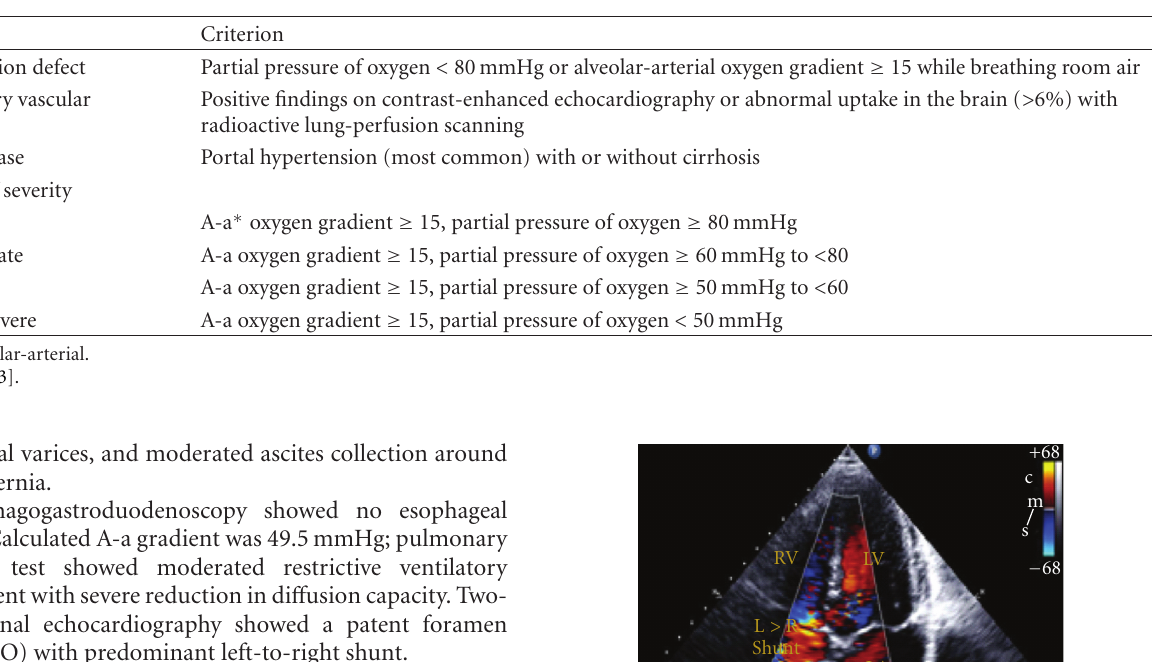
Table 1: Diagnostic criteria for hepatopulmonary syndrome.